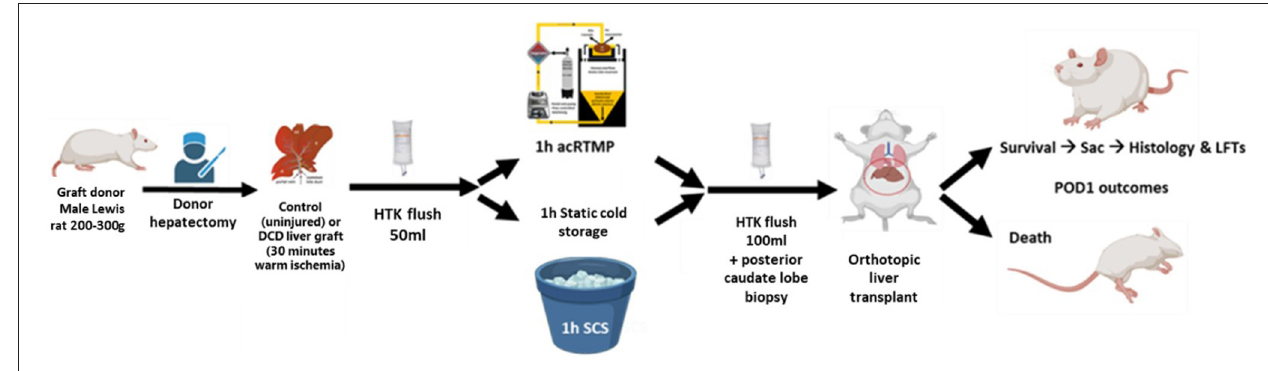
FIGURE 1 | Experimental design. Control and DCD liver grafts were recovered and preserved by 1h of acellular room temperature machine perfusion, followed by orthotopic liver transplantation. Comparisons were made to DCD liver grafts preserved by static cold